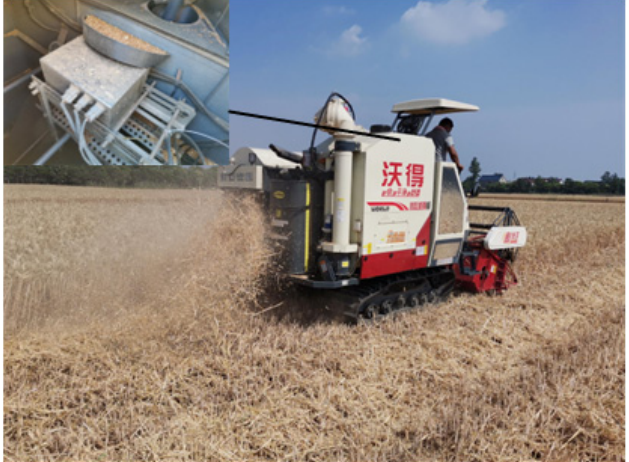
Figure 5. Field validation experiment. (Note: the combine harvester (Wode Ruilong Zhihang version combine harvester, Model 4LZ-7.0EN(Q)), FMWORLD, Danyang, China)